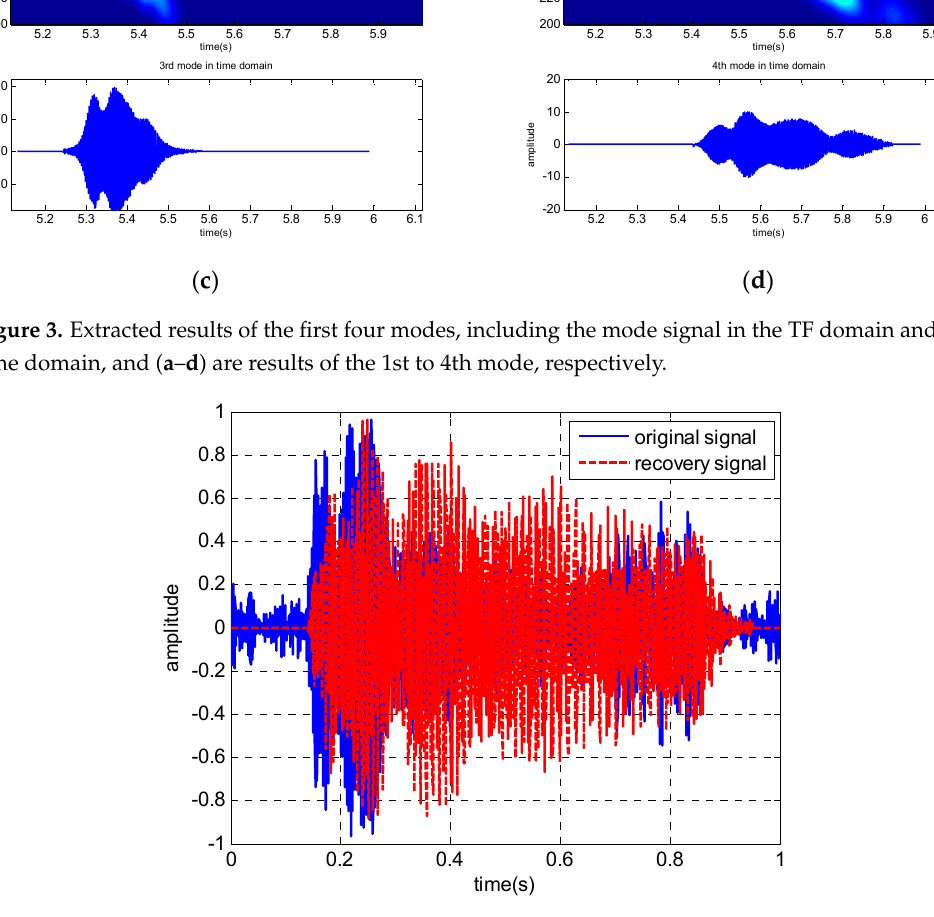
Figure 4. The comparison between the original signal and recovery signal.